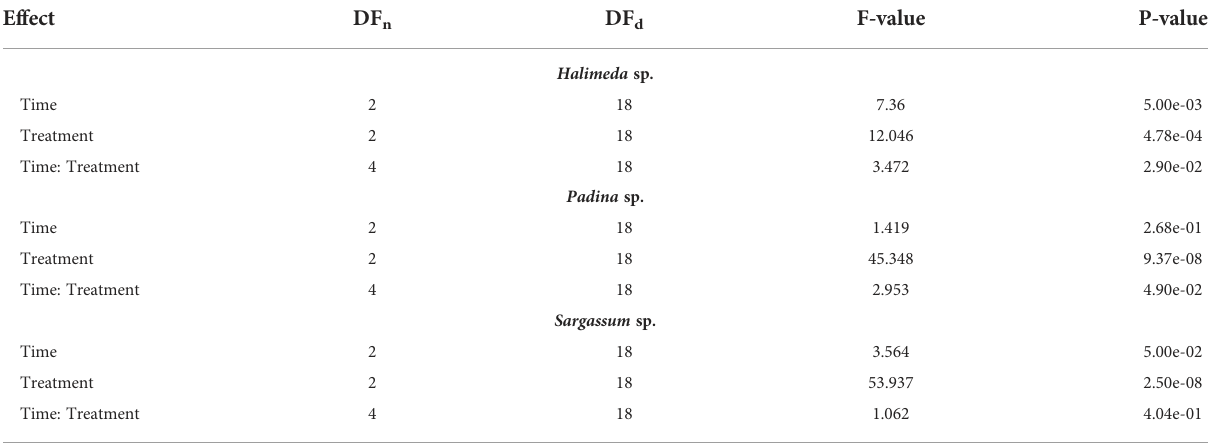
TABLE 4 Respiration rates ANOVA model